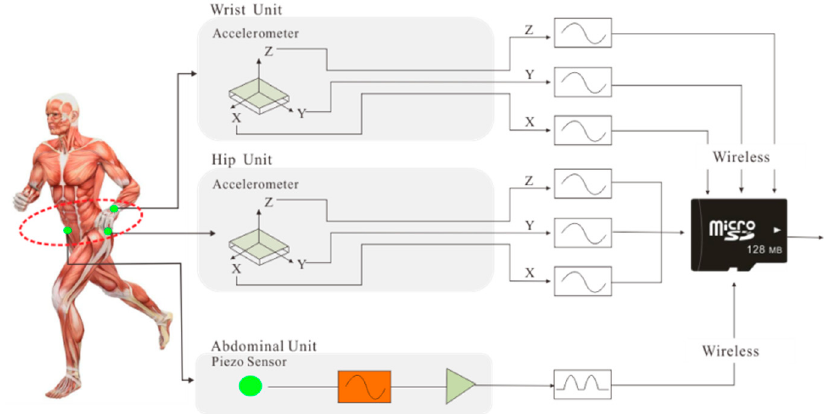
Figure 2. The overall architecture of the IMU system.